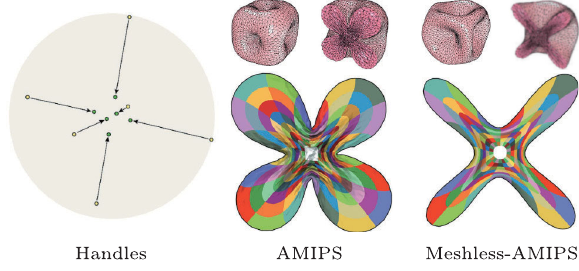
Fig. 5 3D meshless deformation of a spherical tet mesh using AMIPS. Deformed meshes and their cut-views are shown. The meshless deformation generates smooth results. Reproduced with permission from Ref. [14], c (cid:2) ACM